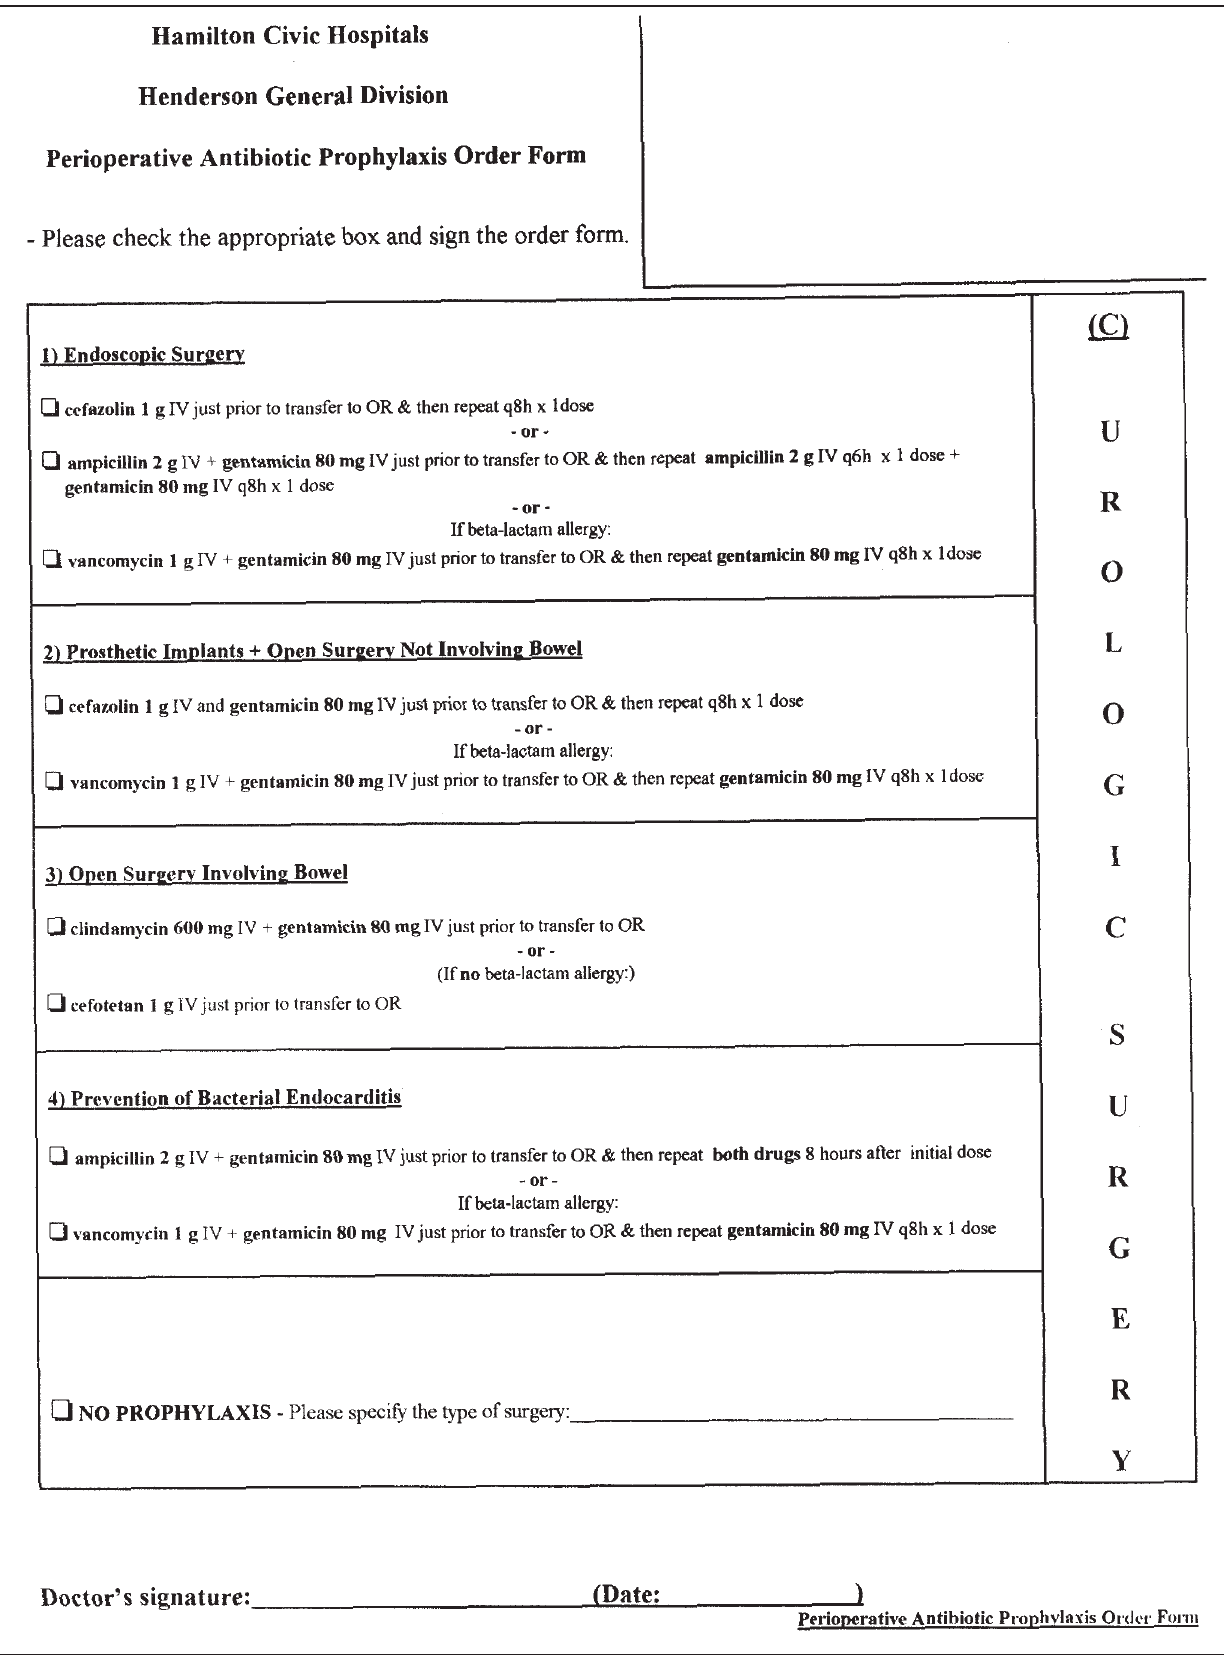
G:\INFDIS\1998\Vol9No3\au.vp Fri Jun 12 09:10:58 1998